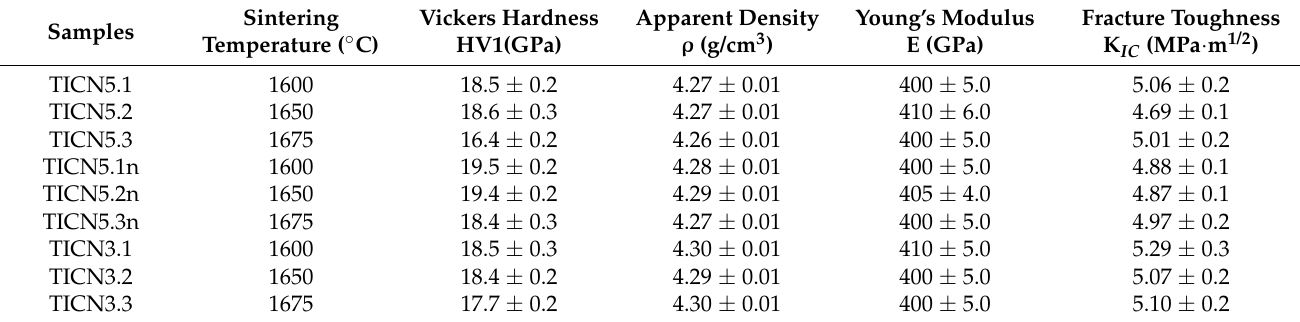
Table 2. Selected mechanical and physical properties of the tested composites sintered using SPS.